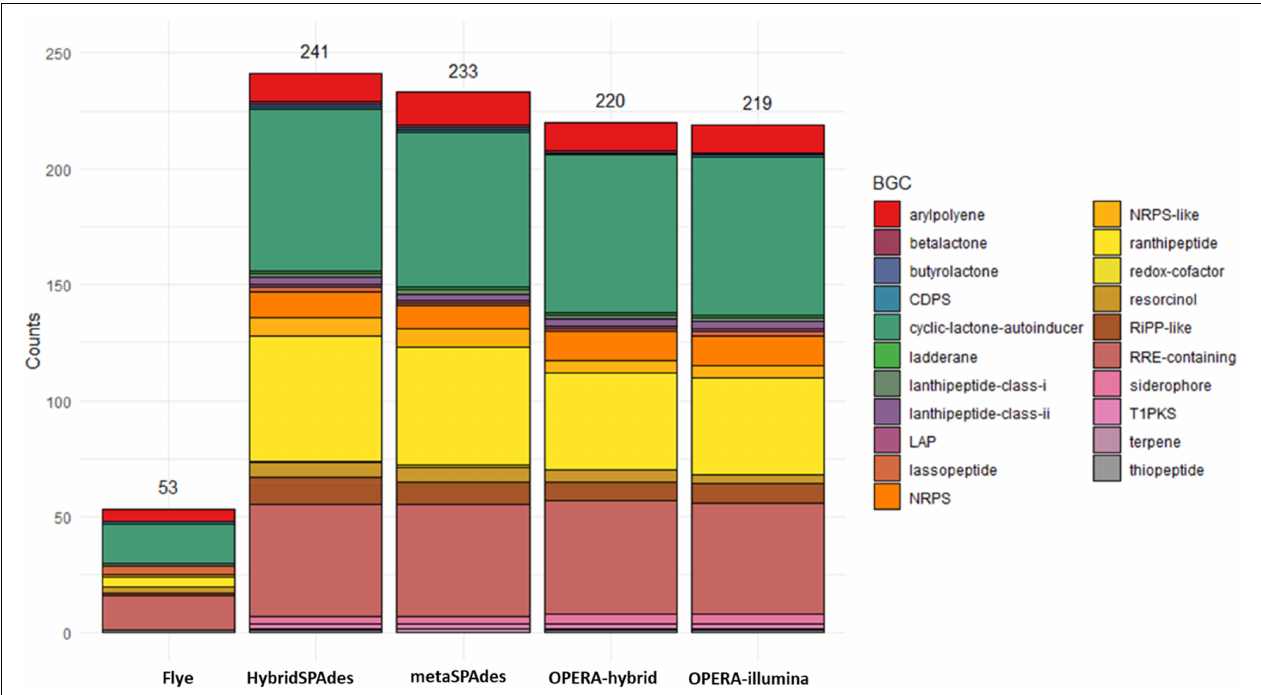
FIGURE 9 | Number of biosynthetic gene clusters (BGCs) predicted by antiSMASH for each draft assembly.